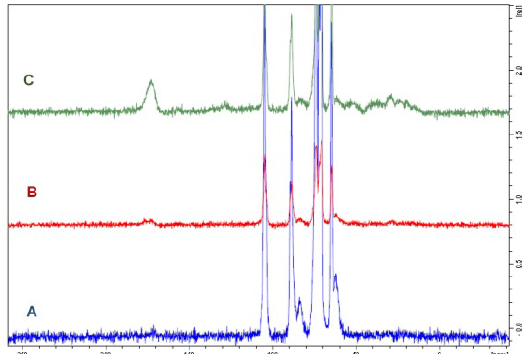
Figure 2. Solid state 13 C nmr spectra of nanocellulose. (A) Pristine NCB; (B) with succinic acid, NCB-suc; (C) conjugated with lipase, NCB-lip. shown in Figure 5. NCB and NCB-suc has average diameters of 30 - 40 nm and average lengths of 300 - 400 nm giving an aspect ratio of ~13. This results in shape, size and aspect ratio agree with what was found by other authors 33-35